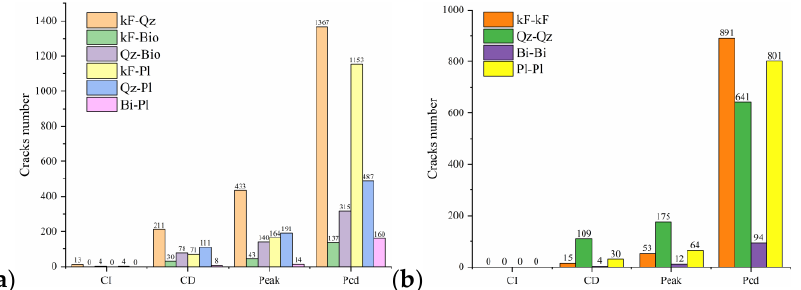
Figure 17. The crack characteristic statistics of Qz, kF, Pl, Bi at the four stress values of σ ci , σ cd , σ peak and σ pcd in the process of grain evolution. ( a ) Different crystals Boundary cracks between grains. ( b ) Transgranular cracks in the same grain composition.